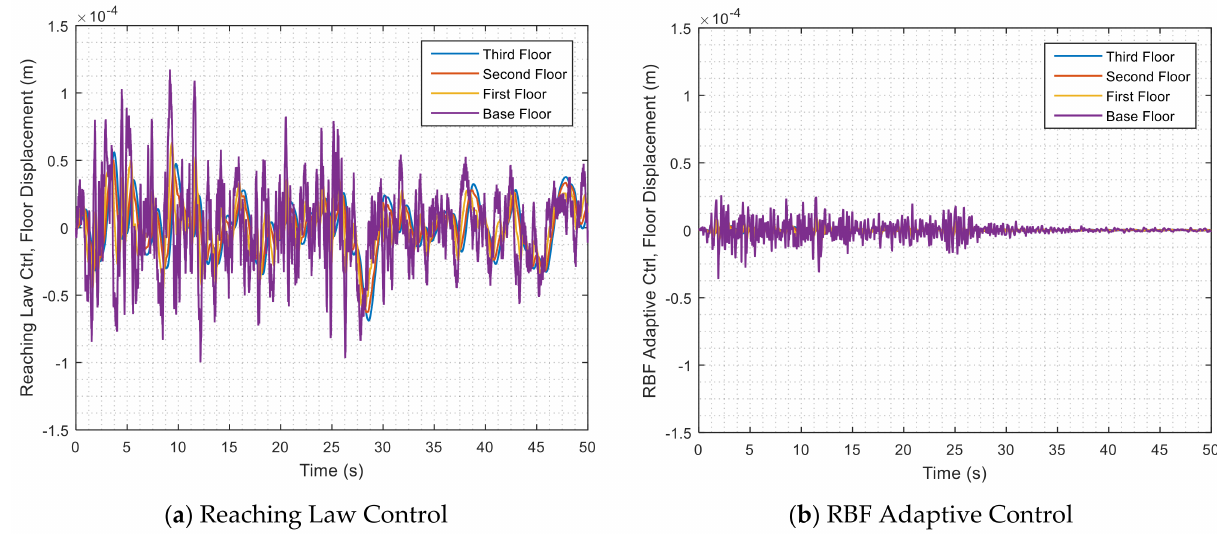
Figure 19. Structural Dynamic